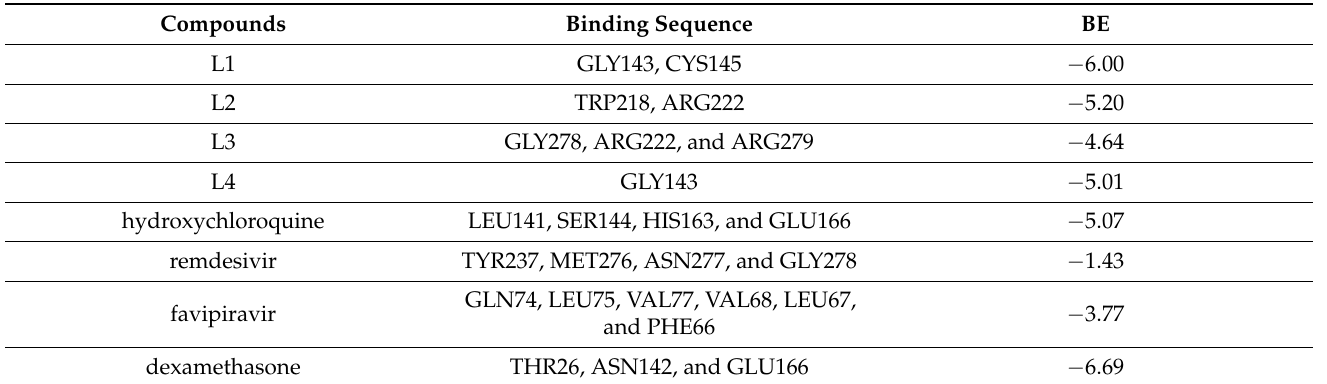
Table 1. Docking modeling investigations were conducted using MOE-docking score energy (DS), the sequencing of ferrocene derivatives and the references, and SARS-CoV-2 (6LU7